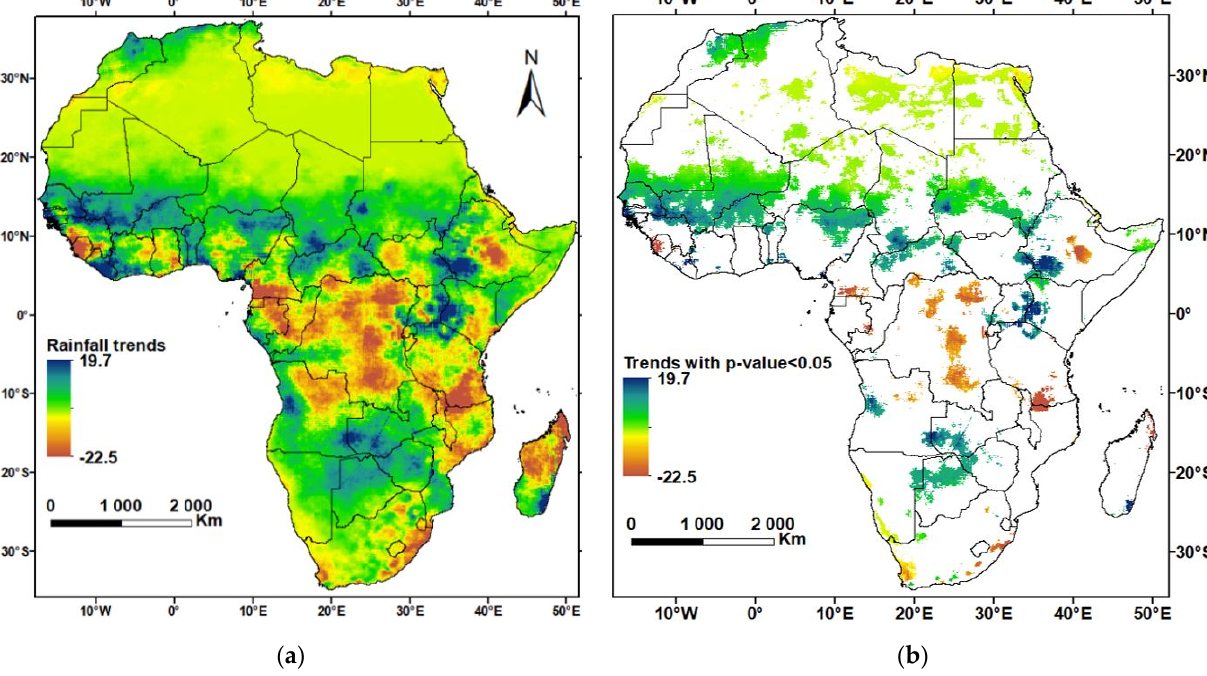
Figure 4. African precipitation. ( a ) Spatial distribution of the annual rainfall change trend on each pixel from 1982 to 2015; ( b ) The figure ( a ) with all pixels with non-significant trends ( p -value < 0.05) masked out.